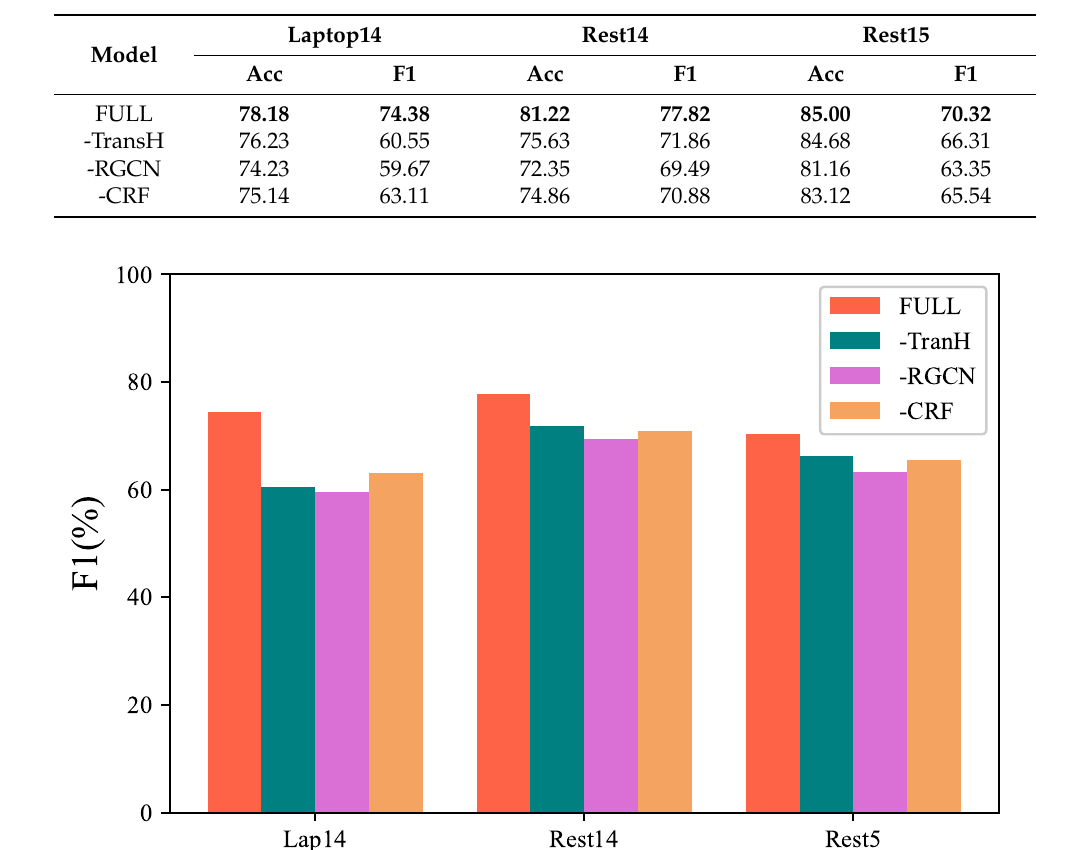
Table 4. The effect of different modules on the model.